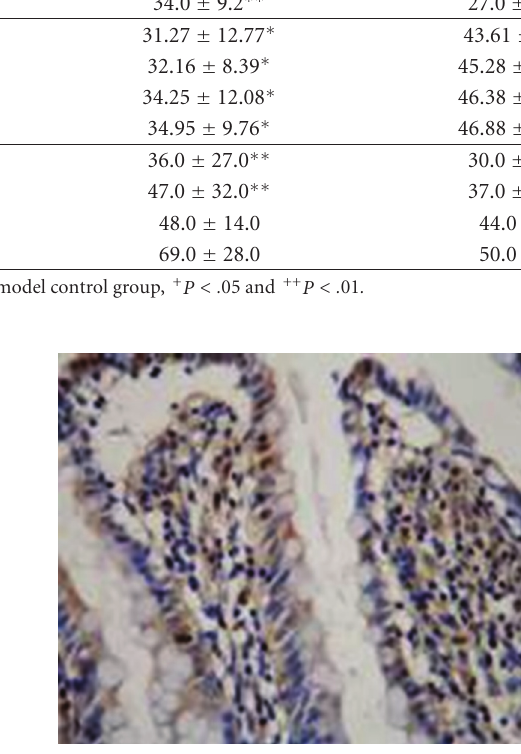
Figure 5: Model control group-28d mucous membrane of small intestine (+++) NF- κ B ×